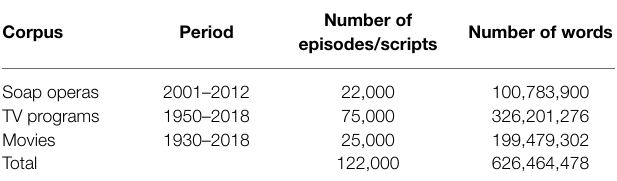
TABLE 2 | General information about the corpora (Davies, 2012, 2019a,b).